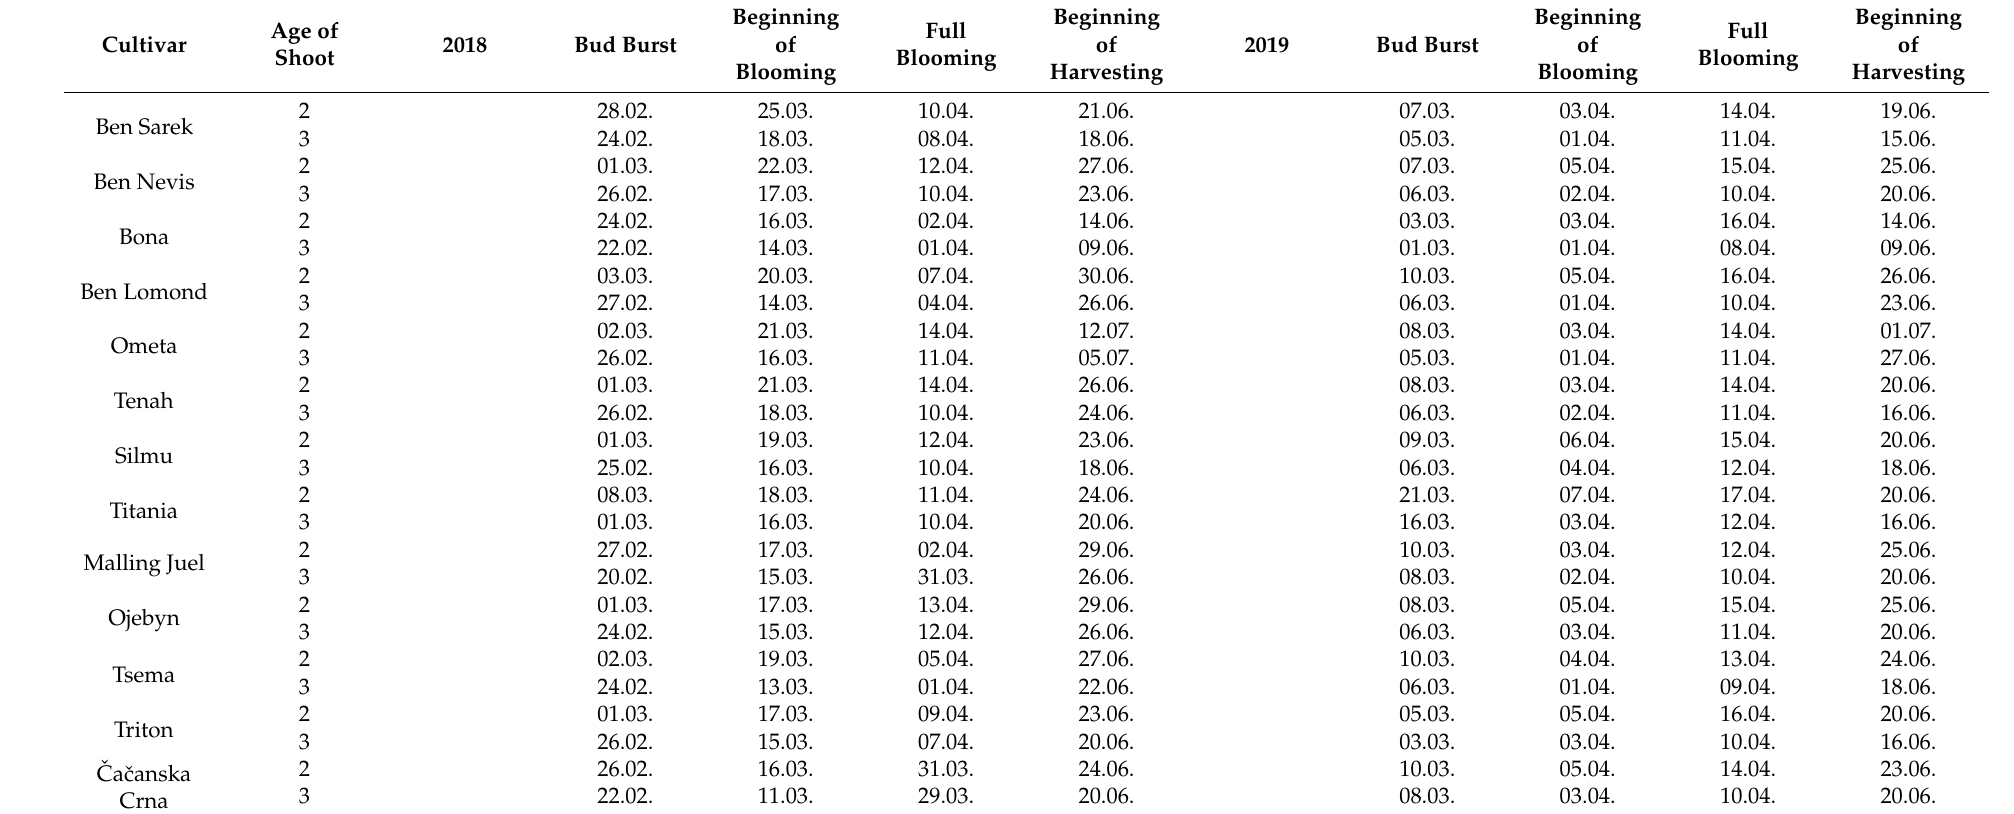
Table 1. Phenological phases of black currant cultivars during 2018 and 2019 year.